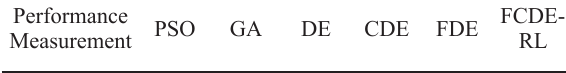
Table 6. Result comparison between FCDE-RL and benchmarked algorithms Performance PSO Measurement